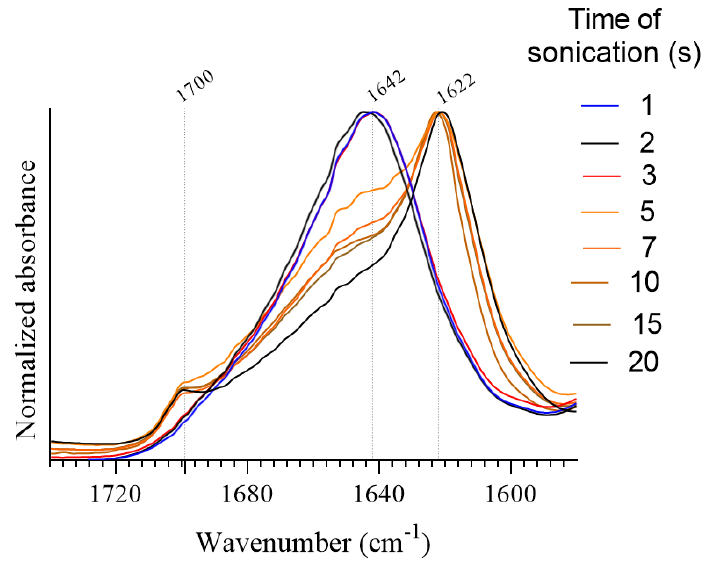
Figure 4. Amide I and II bands of silk fibroin.